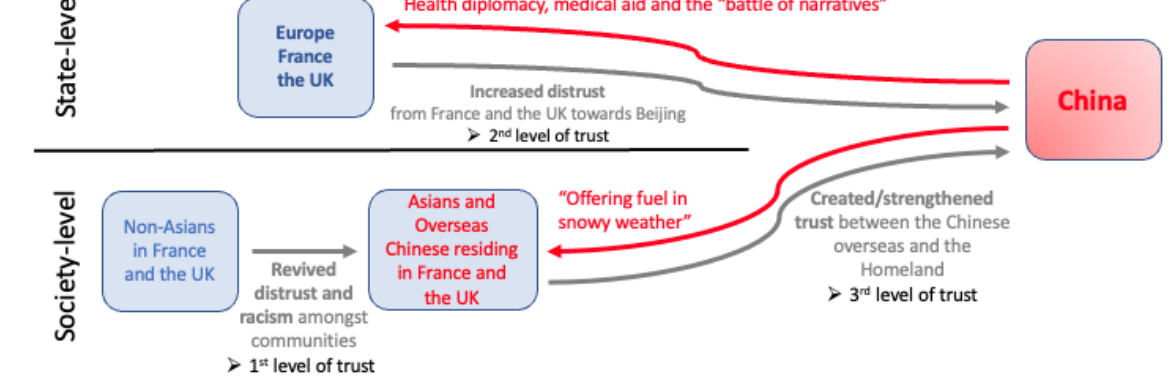
Figure 2. Multilevel (dis)trust in China – Europe relations in the early COVID-19 pandemic. Drawing from this article’s findings, the authors are now inquiring further into China’s adoption of digital diplomacy, including Twitter diplomacy, as the world is re- covering from the pandemic amidst a climate of enhanced tension and the war in Ukraine. regard to dialogue and peace.